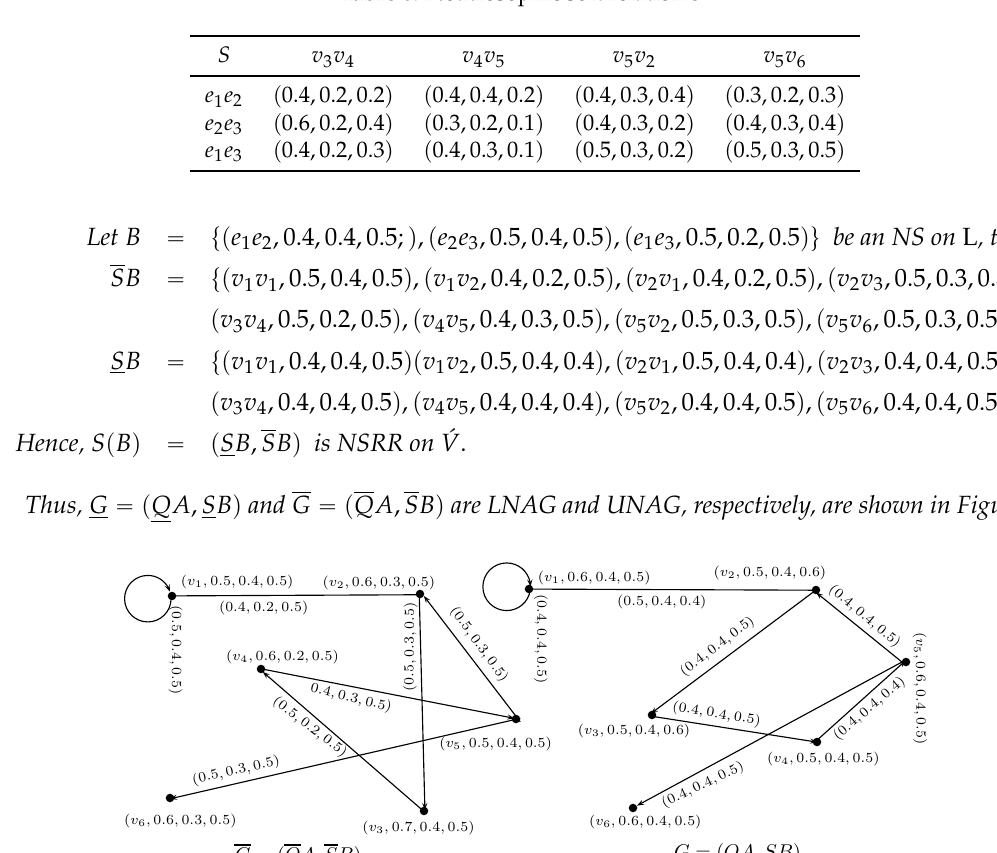
Table 5: Neutrosophic soft relation S